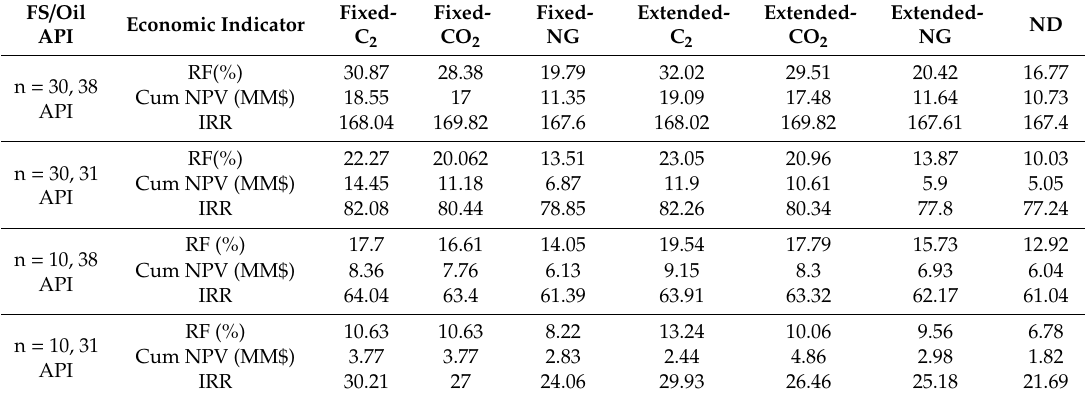
Table 3. High API and low API Oil recovery factor, IRR and cumulative NPV during the reservoir life for n = 30 and n =